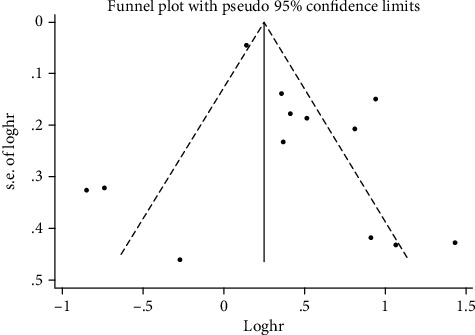
Begg's funnel plot of the included studies for the association between miR-16 expression level and prognosis of solid cancer patients.